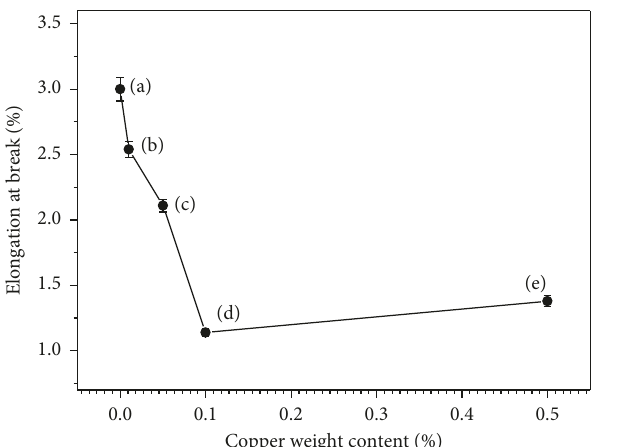
Figure 9: Tensile elongation at break: (a) nylon 6 and nanocomposites with (b) 0.01, (c) 0.05, (d) 0.10, and (e) 0.50wt.% of copper nanoparticles. Table 2: Mechanical properties and standard deviation of Nylon 6 and the nanocomposites. Nylon 6/nano-Cu